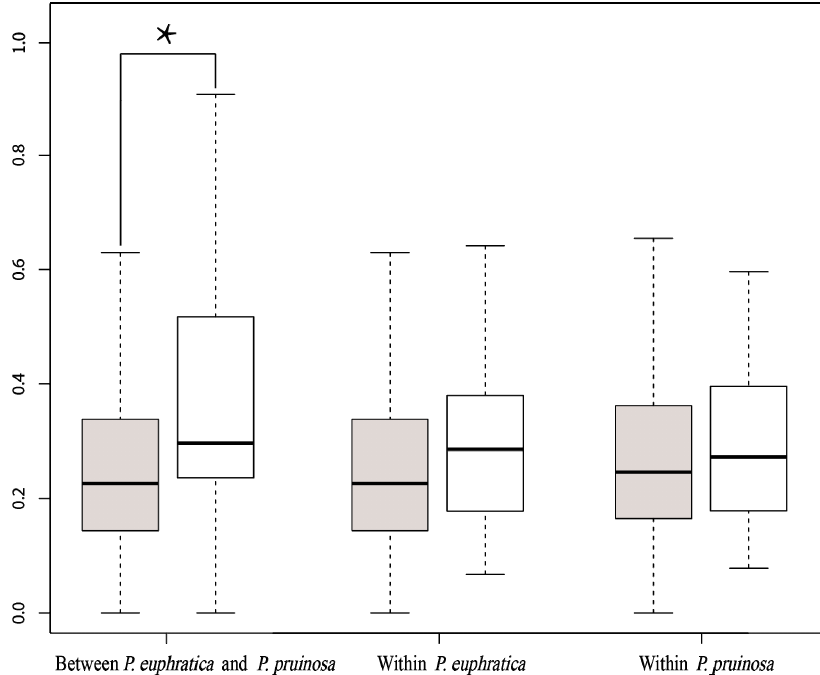
Figure 5. Box plot of nonsynonymous substitution/synonymous substitution (dN/dS) ratios for gene pairs either involved or not involved in trichome formation. Boxes shaded grey show the dN/dS ratios of gene pairs not related to trichome formation. The remainder represent the dN/dS ratios of gene pairs involved in trichome formation. The trichome formation-associated gene pairs have higher dN/dS ratios. Asterisks indicate statistically significant differences.